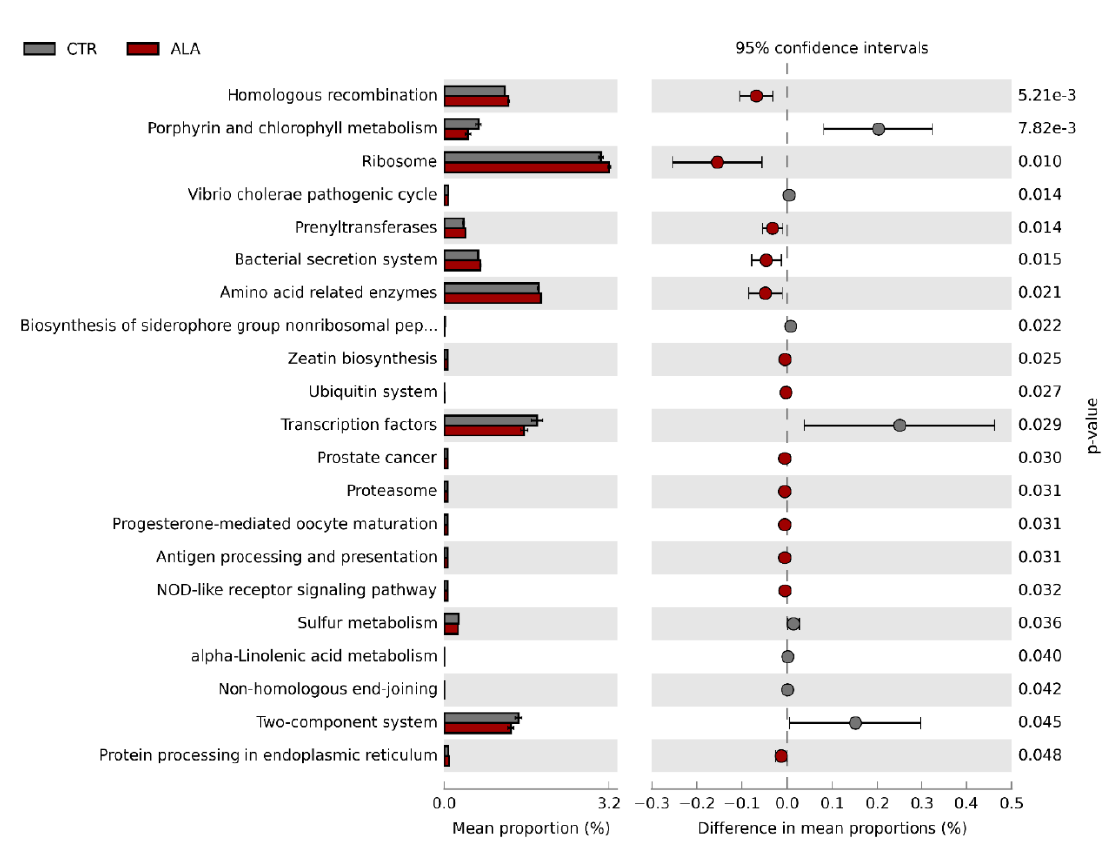
Figure 4. PICRUSt prediction of Kyoto Encyclopedia of Genes and Genomes (KEGG) orthology pathways predicted to be significantly different between the control group and animals receiving ALA-rich diet. Bar plots show the average proportion of sequences, which were predicted to be associated with the respective pathway. Circles correspond to the difference in mean proportions together with the 95% confidence interval. Red circles show pathways, which were enriched in the ALA group. Groups were compared statistically with an unpaired t -test. ALA: α-linolenic acid; CTR: control.